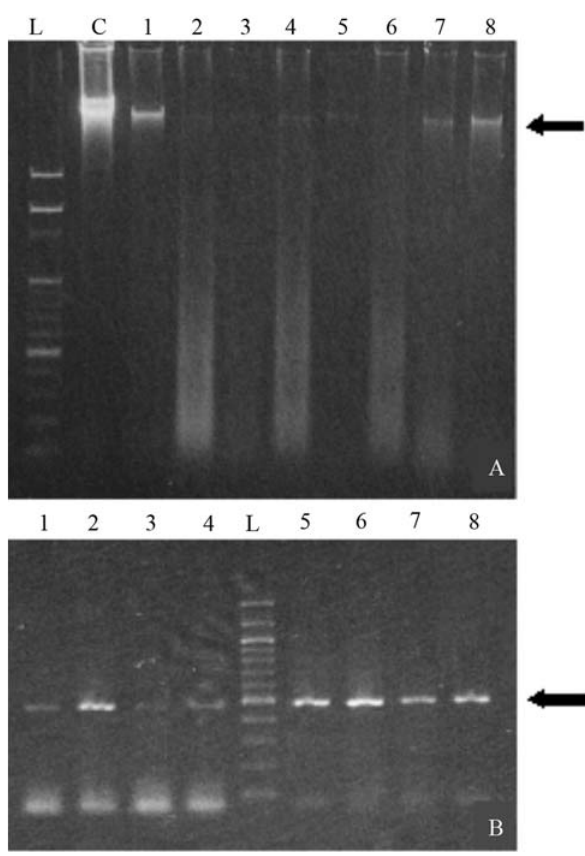
Figure 1 - Gel electrophoresis of A. DNAs (arrow) obtained from a sam- ple of fresh-frozen control group liver tissue (C), lanes 2, 4 and 6 refer to formalin-fixed experimental group liver tissue kept in Tris-EDTA (TE) buffer for one day, while lanes 1, 7 and 8 refer to formalin-fixed muscle (lanes 1 and 7) and liver (lane 8) tissue kept in Tris-EDTA (TE) buffer for seven days. B: Lanes 1 to 4 show 500 bp (arrow) PCR product produced with TaqGen polymerase using DNA template of formalin-fixed tissue, while lanes 5 to 8 show the same product produced using Platinum Taq polymerase. L = 100 bp molecular marker